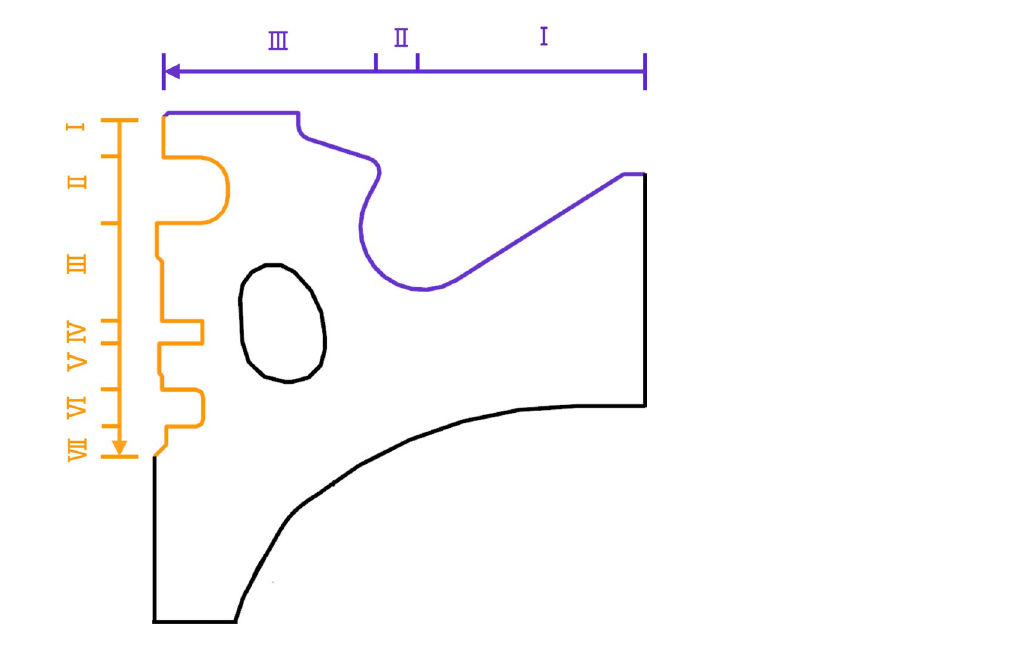
Figure 13. Location of the 50 measuring